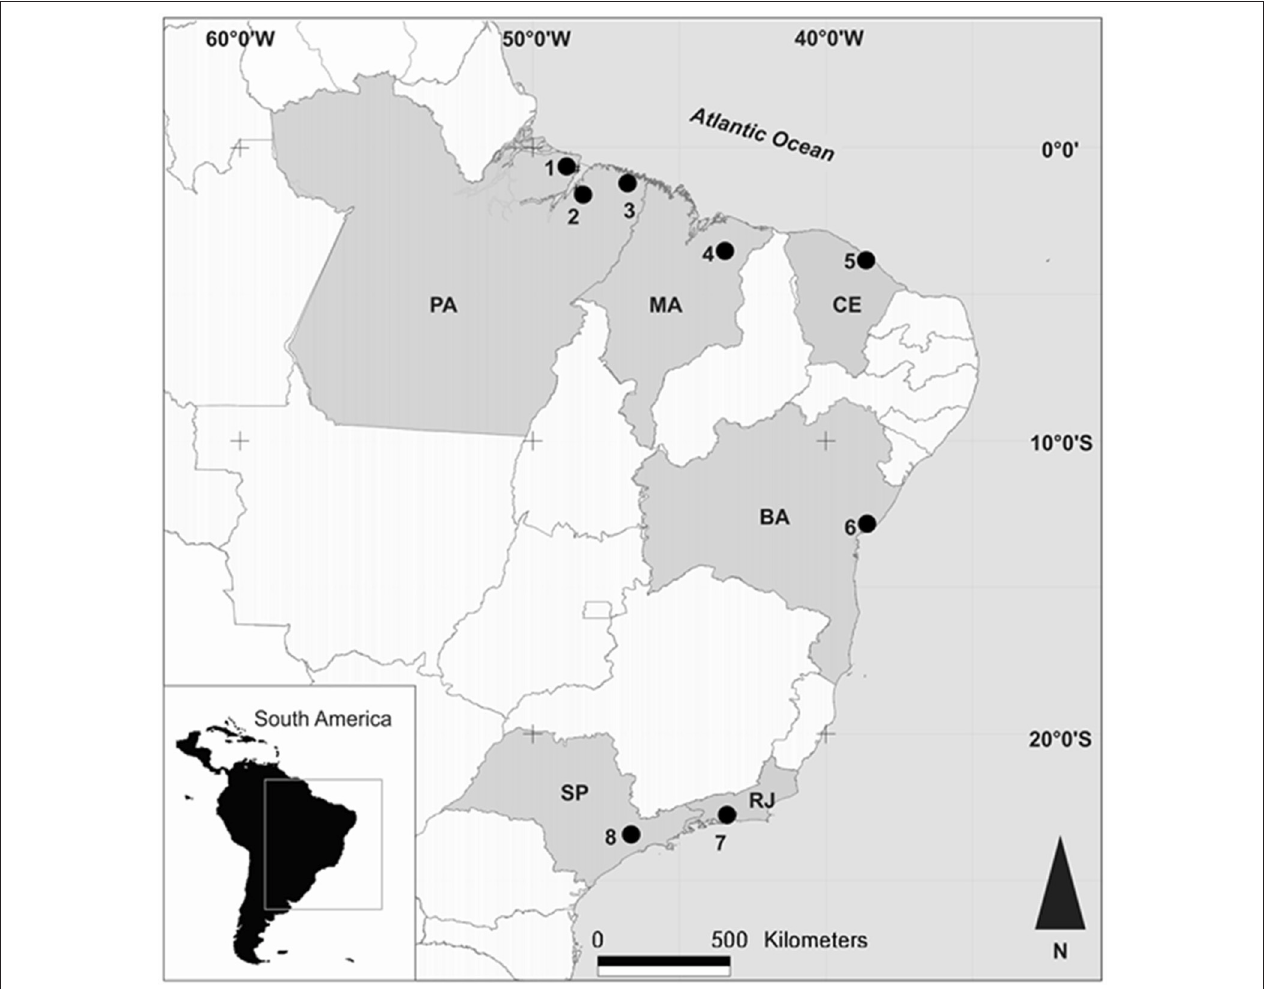
FIGURE 1 | Map displaying the dolphins love charm sampling sites. (1) Soure, PA, (2) Belém, PA, (3) Bragança, PA, (4) São Luís, MA, (5) Fortaleza, CE, (6) Salvador, BA, (7) Rio de Janeiro, RJ, (8) Guarulhos and São Paulo, SP. For more information, see Supplementary